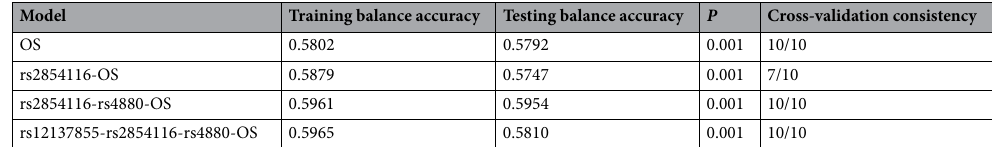
Table 9. Analysis of the GMDR model of OS-gene. Adjusted variables included: Smoking status, drinking status, DASH diet score, physical activity level, sleep quality, BMI, hypertension, HUA, and shift work